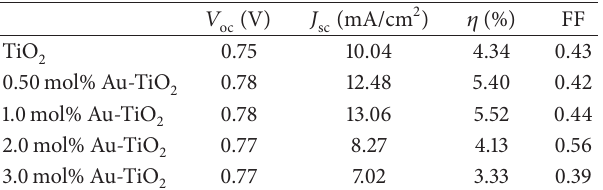
Figure 8: Current density versus voltage ( 𝐽 - 𝑉 ) curves of fabricated DSSCs using TiO 2 and 0.50–3.0 mol% Au-loaded TiO 2 nanoparti- cles. Table 1: Photovoltaic performances of fabricated DSSCs using TiO 2 and 0.50–3.0 mol% Au-loaded TiO 2